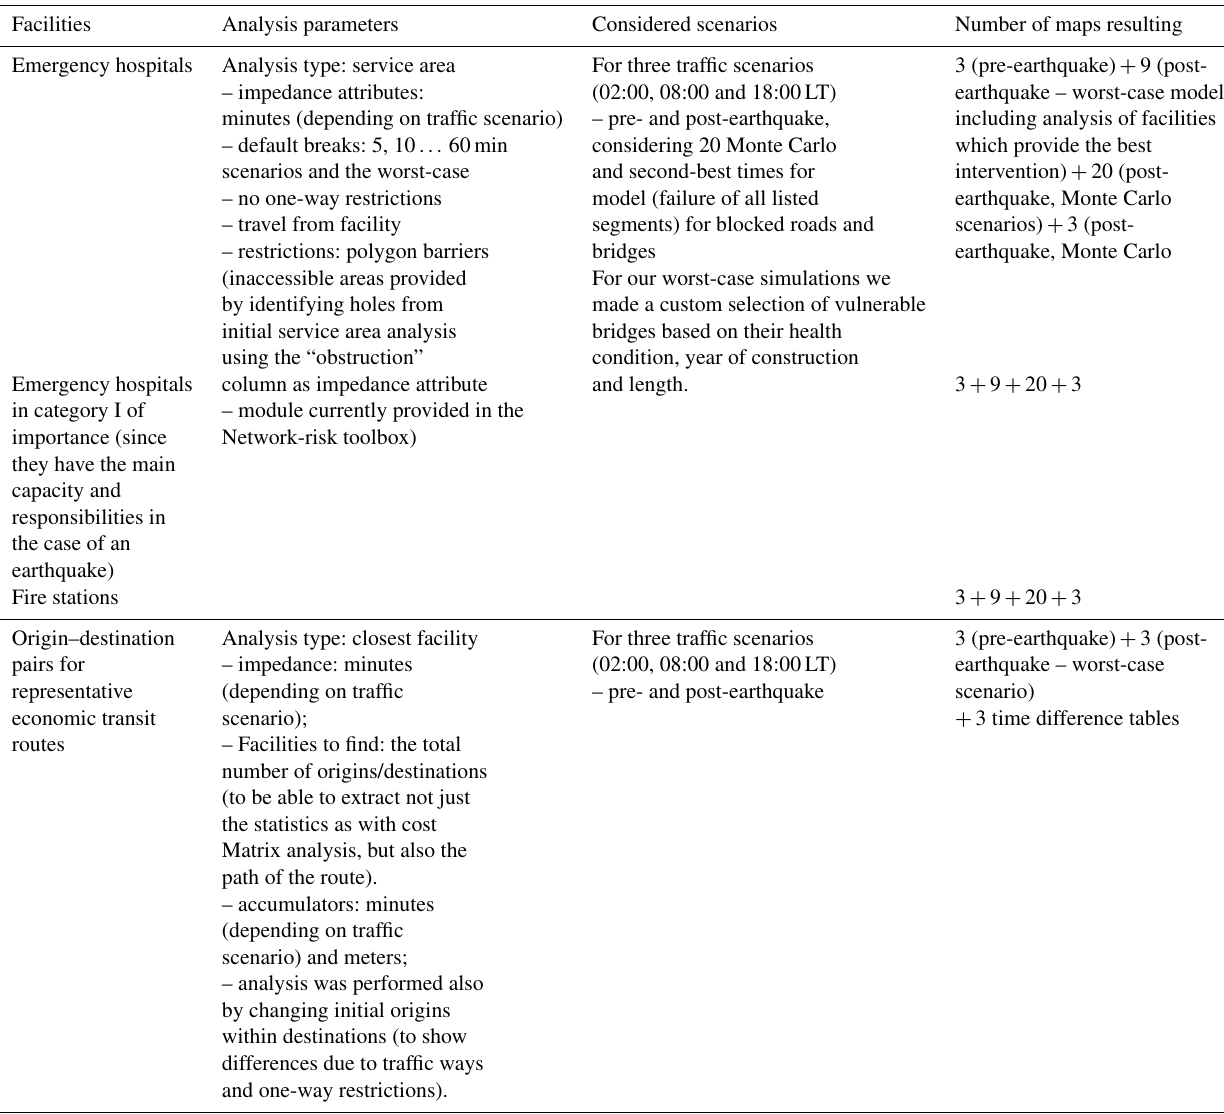
Table 2. Parameters used for of Bucharest post-earthquake road network risk